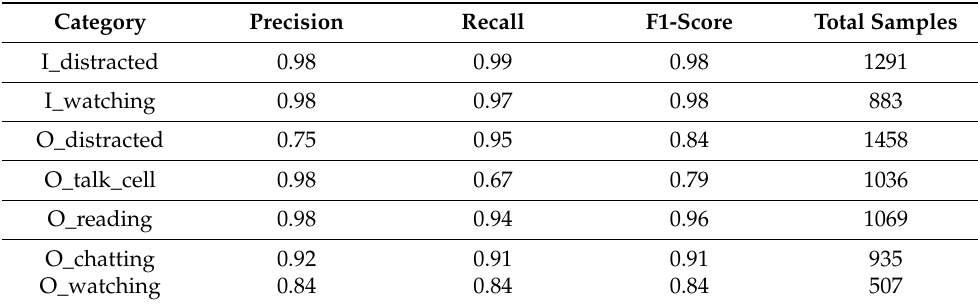
Table 8. Evaluation metrics of the Inception-v3